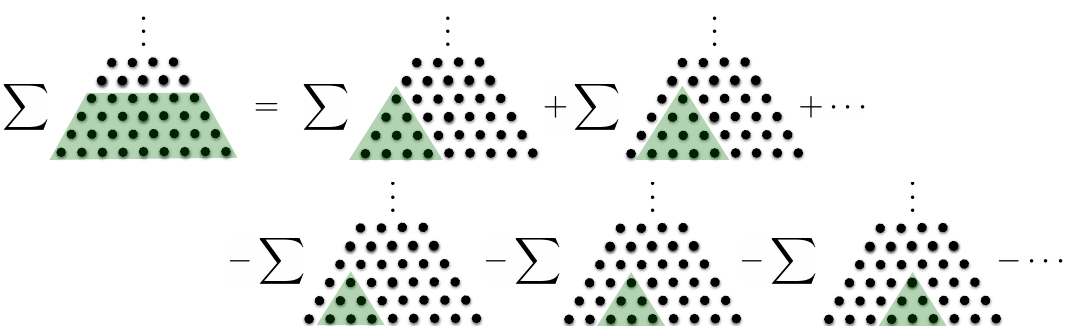
l Figure 9: corresponds to summing over an isosceles trapezoid in the information tot I lattice. As is visualized in the figure, this sum can be recast into a sum over triangles which sum up to the total information corresponding to the neighborhood at the tip of the triangle (12). So we get that the sum runs over all n except the ones corresponding to the left and the right most